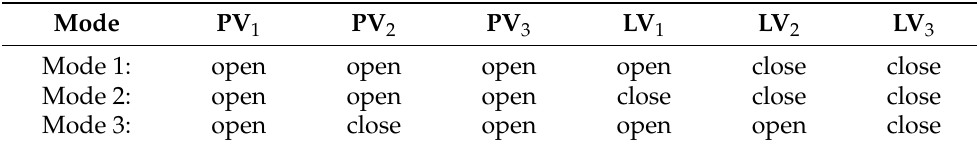
Table 1. The three modes of the three-tank